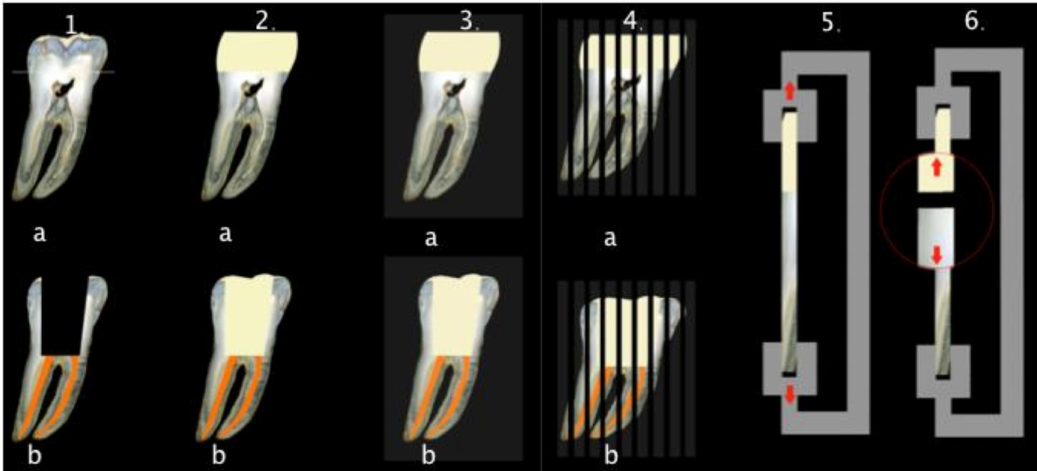
Figure 2. Experimental setup: ( 1.a ) In the first group (n = 20), molar teeth had coronal dentin exposed by cutting of occlusal enamel using diamond blade of Isomet saw to obtain a flat dentin surface for adhesive procedure. ( 1.b ) In the second group (n = 20), root canal treatment of molar teeth was performed. ( 2.a ) and ( 2.b ) In both experimental groups (n = 40), composite build-ups were made with the test (fiber-reinforced) or control (particulate filler) composite. ( 3.a ) and ( 3.b ) After composite build-ups, all teeth were embedded into acrylic resin in order to prepare them for sectioning. ( 4.a ) and ( 4.b ) Teeth were sectioned longitudinally using a diamond blade of Isomet saw to obtain 1 × 1 mm 2 beam-shaped sticks. ( 5. ) Each stick was glued to metal plates and placed in universal testing machine and a tensile load was applied at a crosshead speed of 0.5 mm/min until ( 6. ) the stick fractured and maximum load at failure was